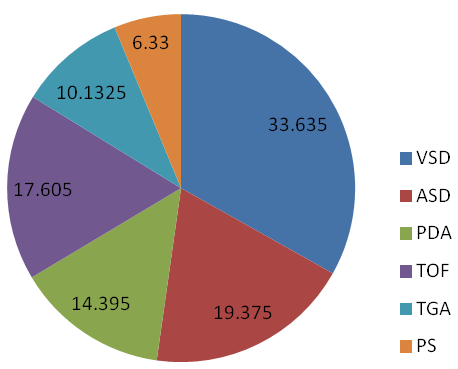
Figure 1. Incidence of different types of congenital heart defects. VSD, ventricular septal defect; PS, pulmonary stenosis; PDA, patent ductus arteriosus; ASD, atrial septal defect; TGA, transposition of the great arteries.